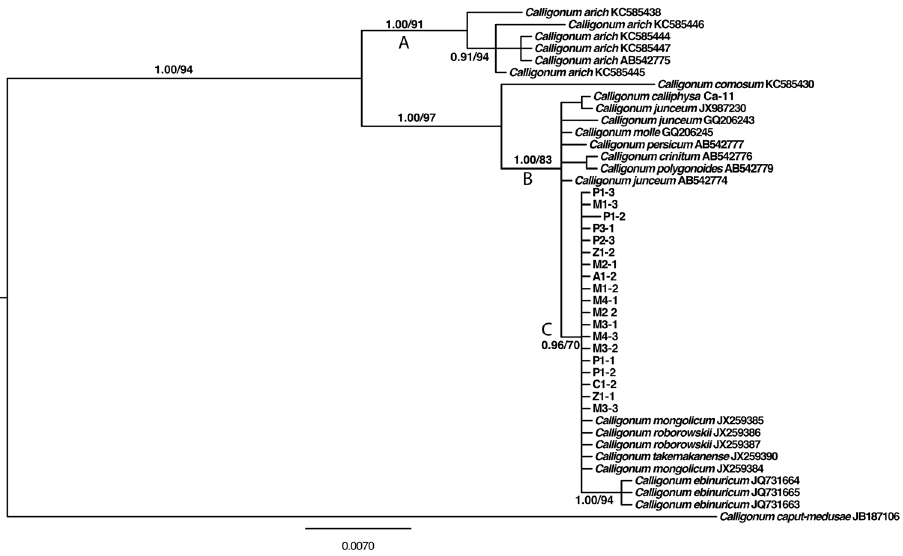
Figure 3. Maximum likelihood tree for 43 (in-group) Calligonum nrITS and ETS sequences produced with RAxML. Numbers adjacent to (relevant) nodes represent maximum likelihood value and Bayesian posterior probabilities. Branches marked with an asterisk collapse on the maximum likelihood strict con- sensus tree of the same dataset. The branch marked with a number sign collapses on the Bayesian majority rule consensus tree of the same dataset.